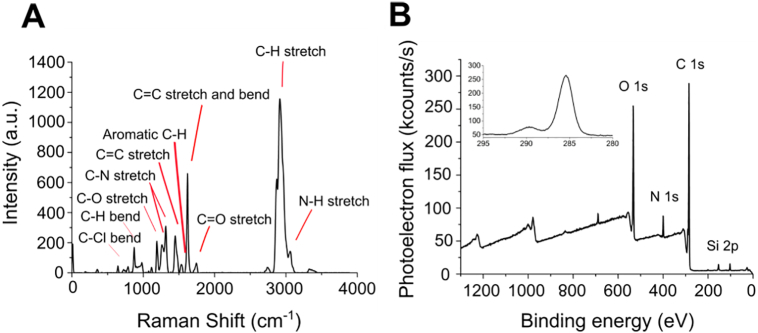
Chemical characterisation of POSS-PCUU scaffold surfaces. (A) Representative Raman spectrum of POSS-PCUU surface with bond information outlined. (B) Representative X-ray photoelectron spectrum of POSS-PCUU surface indicating presence of O 1s, N 1s, C 1s and Si 2p. Survey spectrum inset.